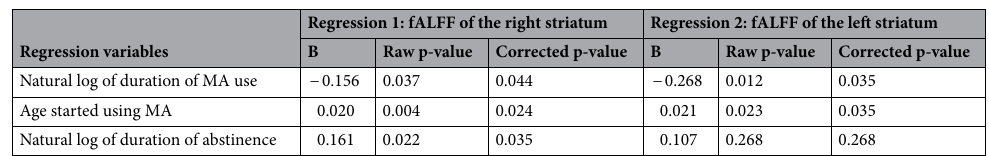
Table 3. Regression results.